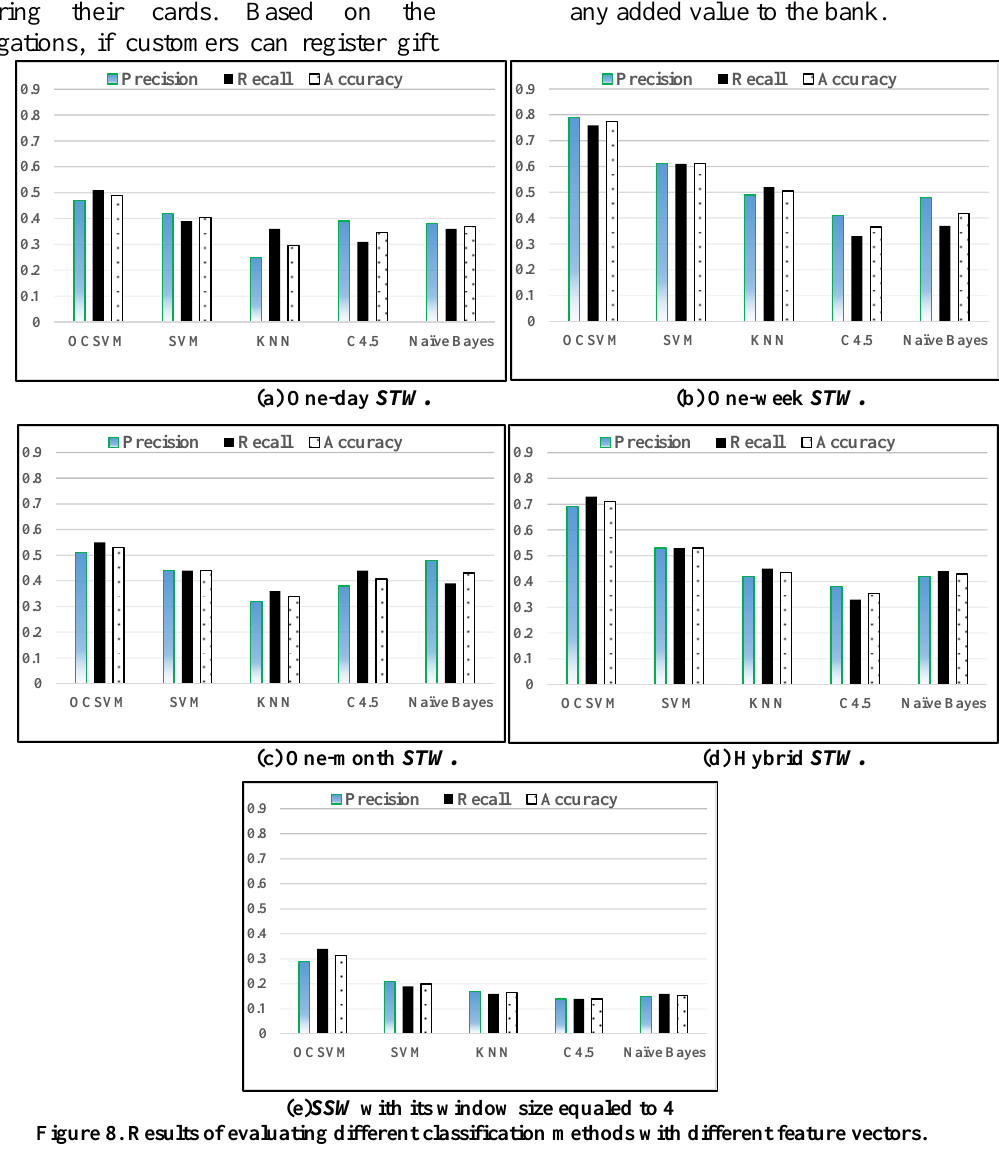
Figure 8. Results of evaluating different classification methods with different feature vectors.